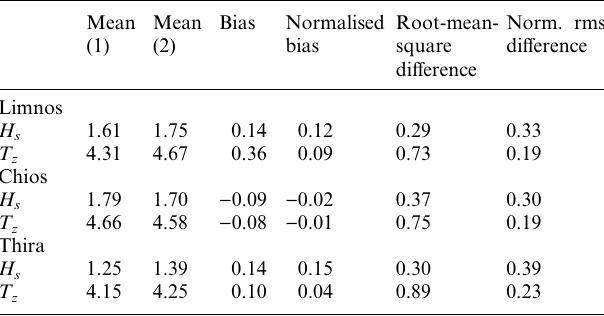
Table 14. Statistics for the storm January 1991, -136 points. Comparison of results from WAM and AUT wave model using